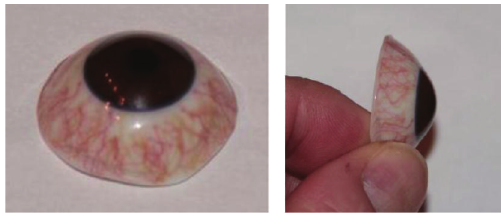
Figure 7: Artificial glass eye (extraocular prosthesis).